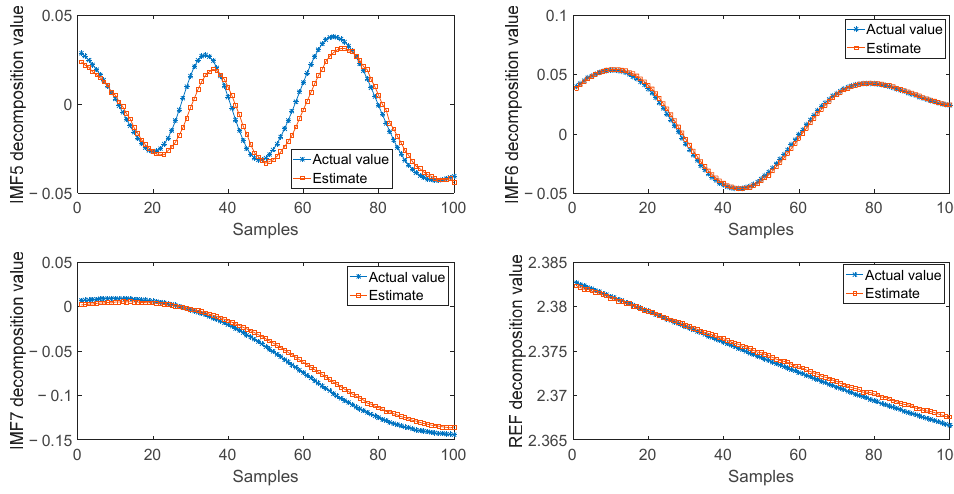
Figure 12. The predictive comparison of IMF5, IMF6, IMF7 and REF components. The evaluation indexes of the comparison between the predicted value and the actual value of the corresponding components of the soft-sensing model of PSO–DBN corre- sponding to each IMF component and REF trend component are shown in Table 1, and the number of hidden layer nodes optimized by the PSO algorithm is given too. Table 1. Evaluation indexes of soft-sensing models for IMF components.